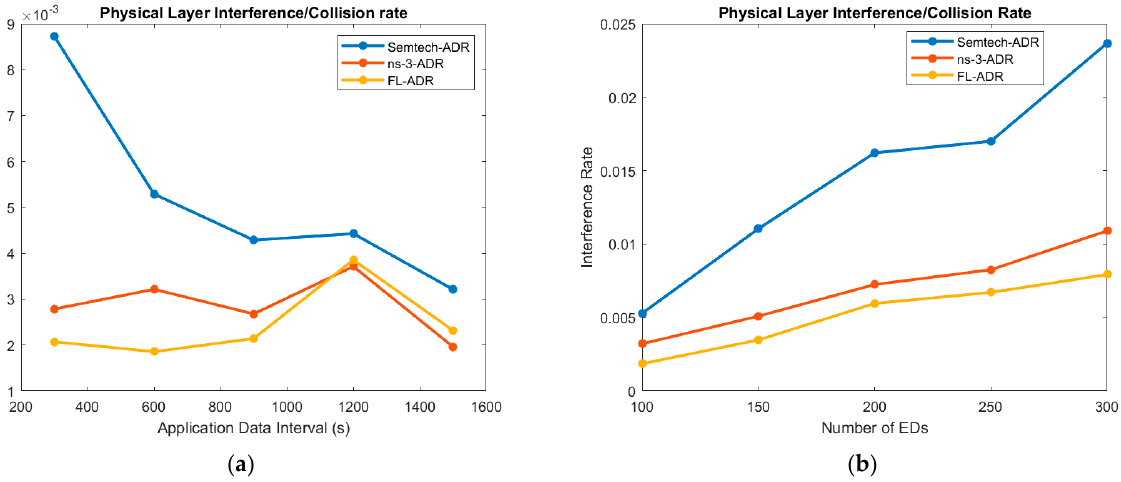
Figure 8. Interference/collision rate: ( a ) data interval vs. interference/collision rate; ( b ) no. EDs vs. interference/collision rate.